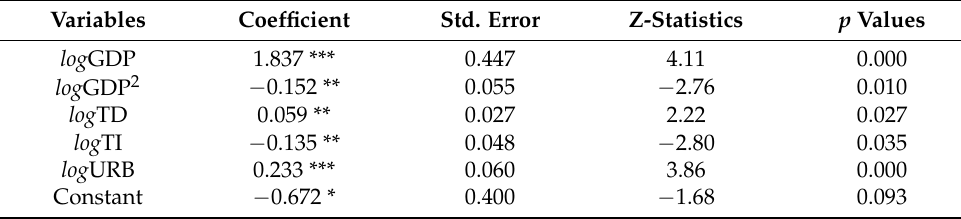
Table 9. Robustness test (CCEMG).